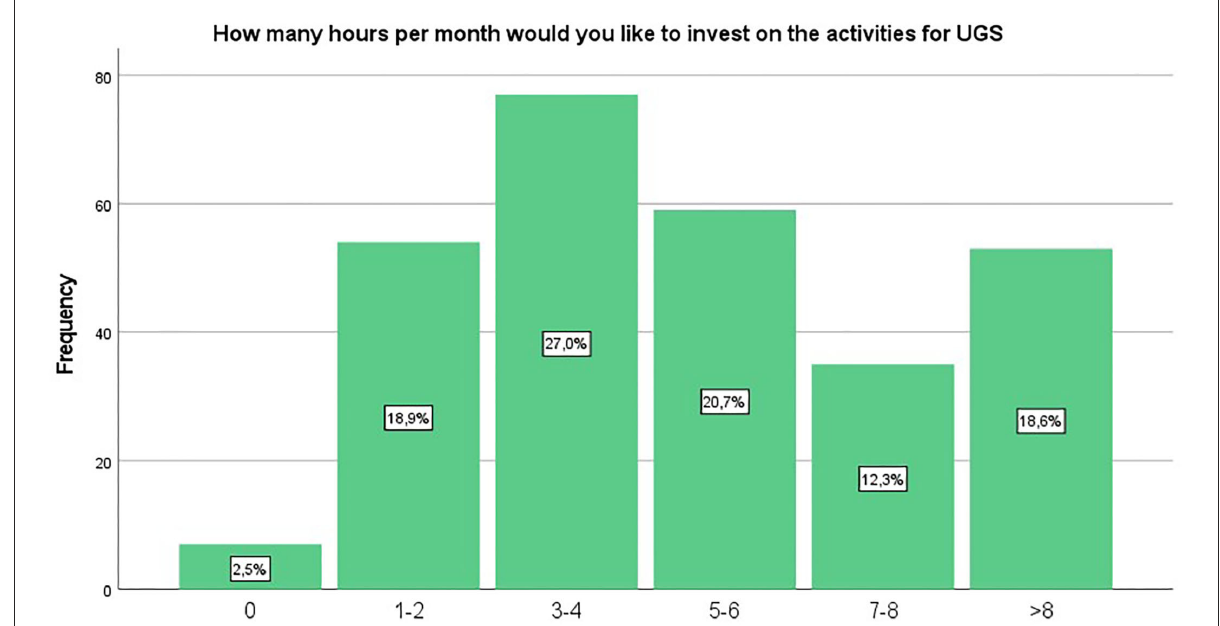
FIGURE4 Hours per month people would like to invest on UGS activities ( n = 285; respondents who answered that they are not willing to participate were excluded here) Note: People willing to participate and answered to invest 0h on the activities for UGS possibly are willing, but do not have time for